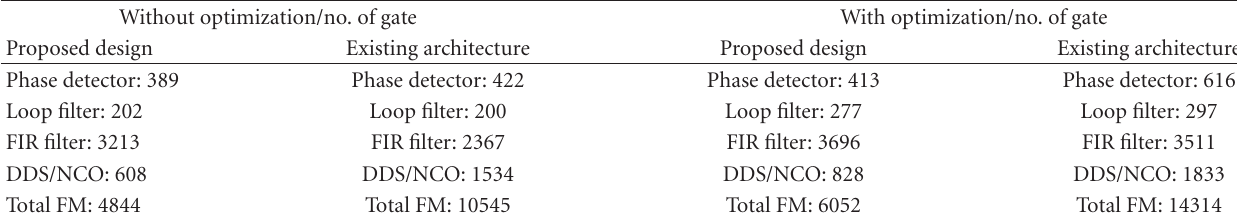
Table 7: Area utilization comparison with other FM demodulator implementations [5, 6].